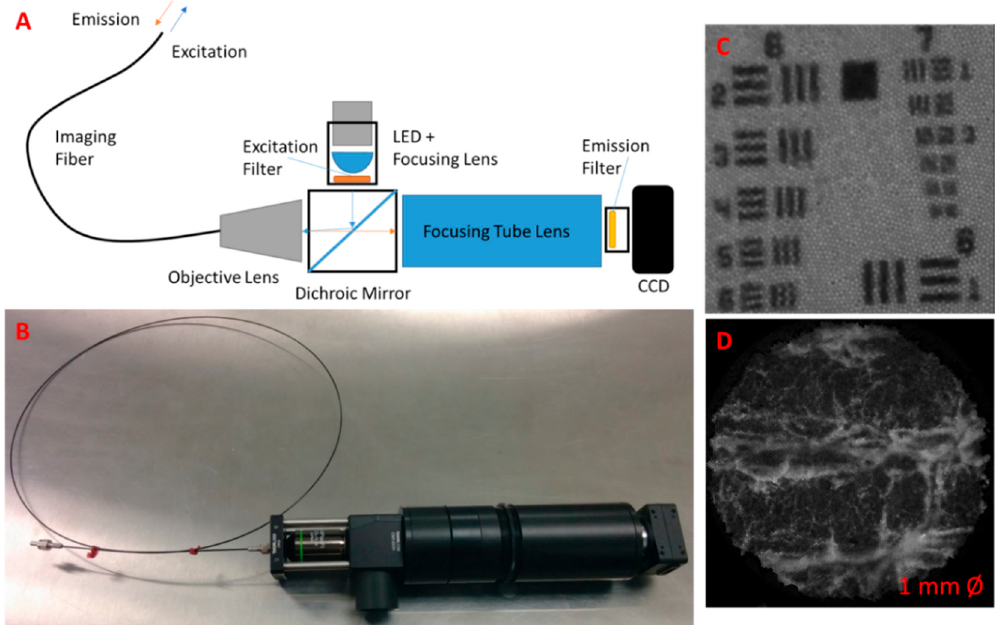
Figure 2. Fiber-optic fluorescence microscope for multiscale functional imaging. ( A ) Schematics of optical instrumentation, ( B ) photo of fiber optic fluorescence microscope prototype; ( C ) USAF resolution target. The system achieves fine resolution down to approximately a smallest dimension of 17.54 µm; and ( D ) the microscope can image intricate fluorescent tissue morphology.